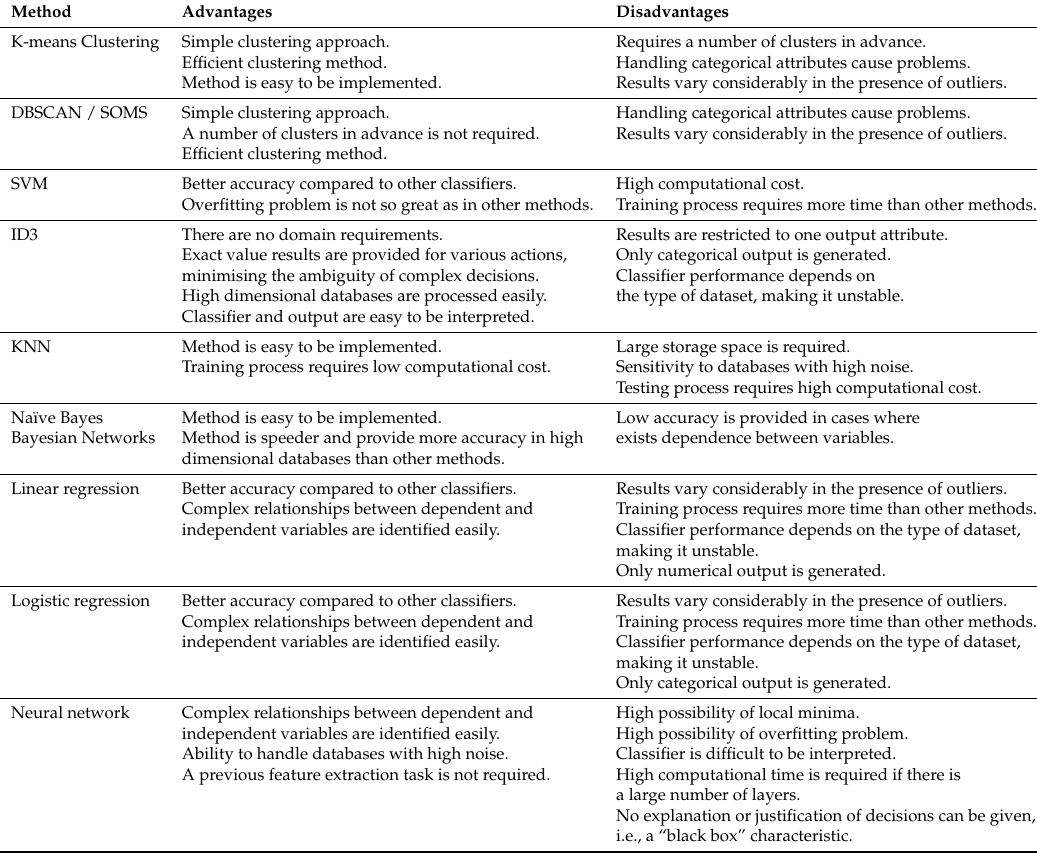
Table 5. Advantages and disadvantages of described